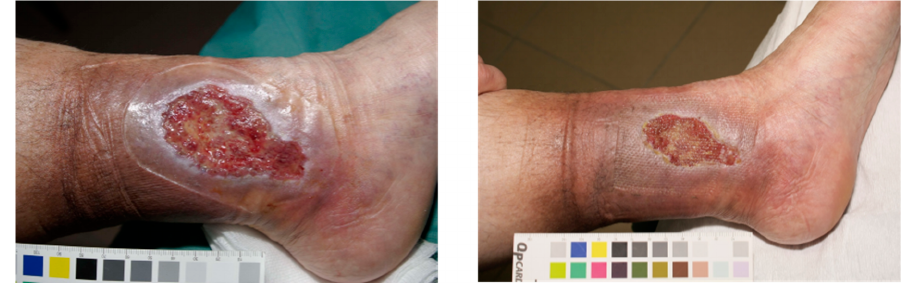
Figure 11. The effect of phenolic compounds derived from the flax dressing on the wound healing. Left picture presents the wound before treatment and the right presents the wound after the 12 weeks of treatment (based on the unpublished data from research of Szopa et al. ).